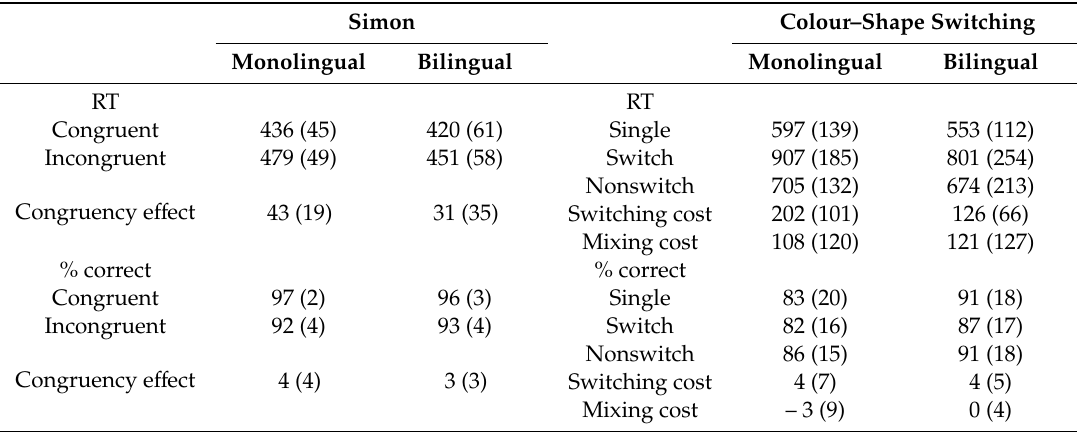
Table 2. Mean reaction times (RTs, ms) and accuracy (% correct) for the Simon task and colour–shape switching task, with standard deviations in